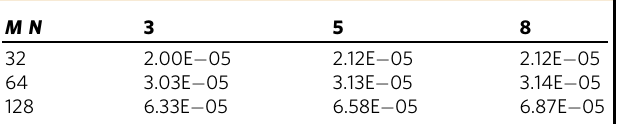
Table 2 Decomposition time (in seconds) using the presented algorithm.